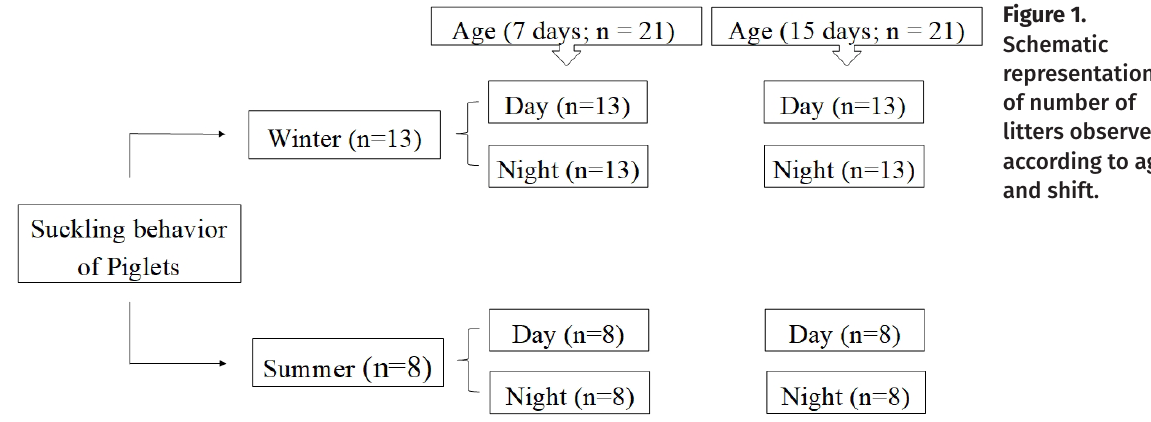
Figure 1. Schematic representation of number of litters observed according to age and